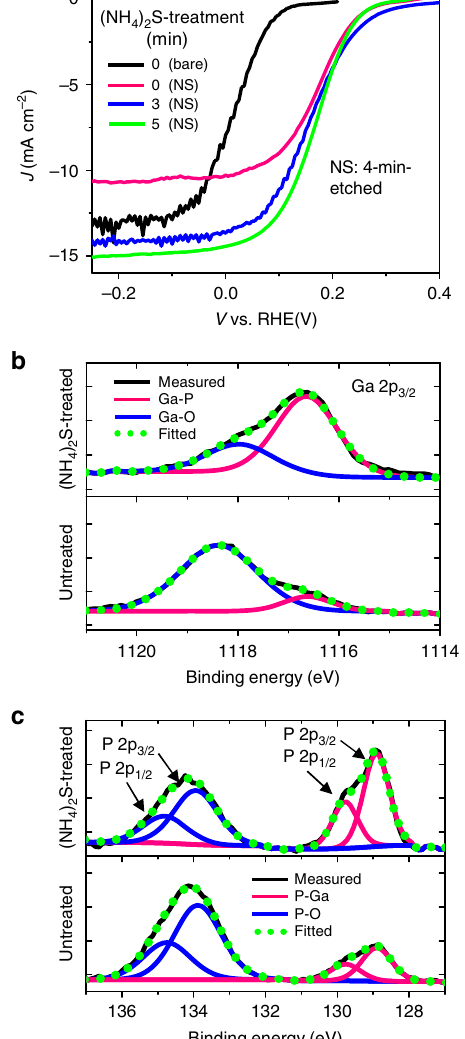
Fig. 3 Photoelectrochemical performance of nanostructured and (NH 4 ) 2 S- treated GaInP 2 photocathodes for the HER. a Representative J-E curves of bare and nanostructured GaInP 2 photocathodes for the HER after the (NH 4 ) 2 S-treatment of 3 and 5 min, measured under simulated AM1.5 G solar illumination (1000 W/m 2 ). XPS spectra of b Ga 2p 3/2 and c P 2p 1/2 and 2P 3/2 for nanostructured GaInP 2 before and after the (NH 4 ) 2 S- treatment (15 J – E curves of 4-min etched GaInP 2 photocathodes before and after the (NH 4 ) 2 S-treatment, plotted with the data for bare GaInP 2 as a reference. For samples before the sulfur passivation,